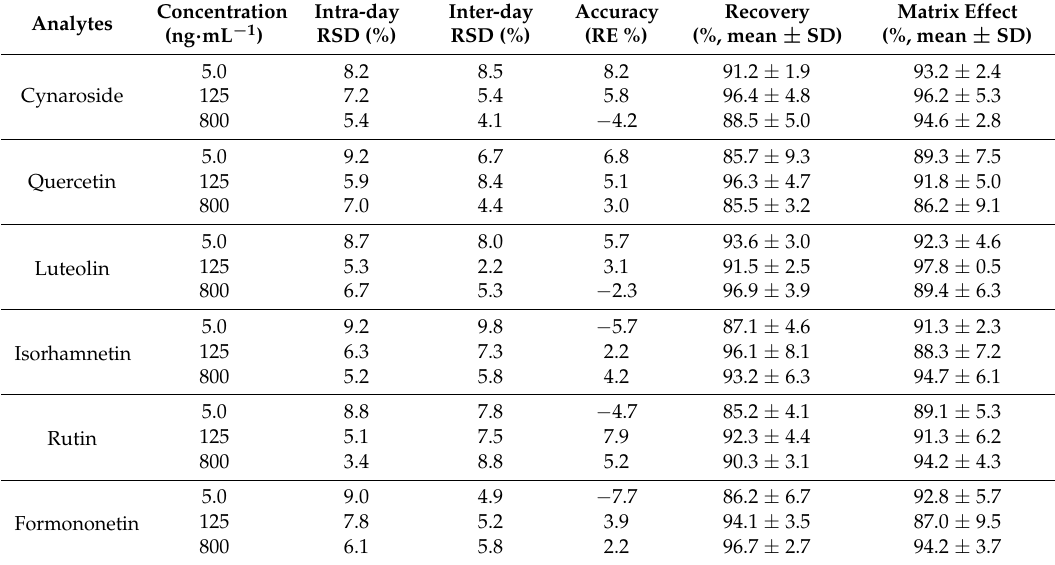
Table 2. Summary of accuracy, precision, recovery and matrix effect of the six analytes in rat plasma ( n = 6).